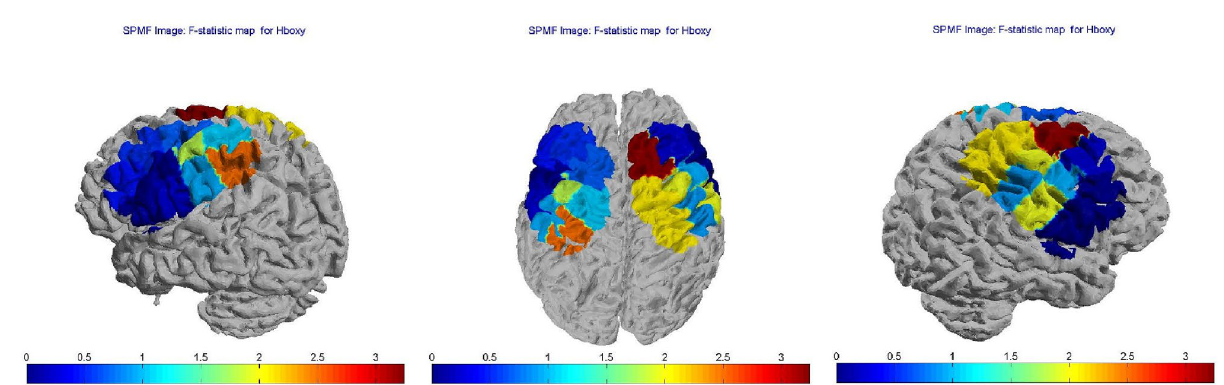
Figure 6. Topographic maps of F-statistic in the comparison among session (Time-to-contact detection vs Observation-only) and groups (FM patients vs controls). Blue areas represent channels with no significant change in hemoglobin levels, red areas represent channels where the variations in hemoglobin levels were significant.